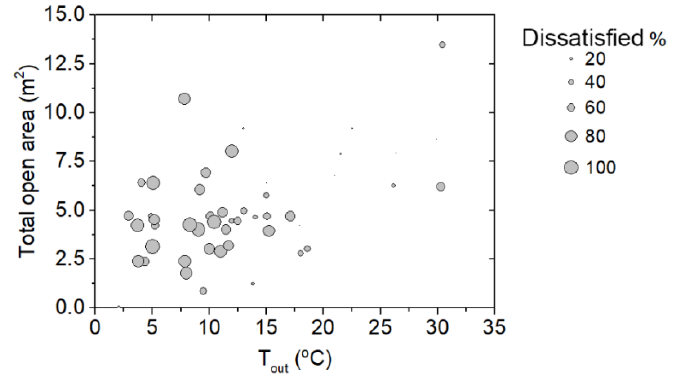
Figure 10. Relationship between the percentage of dissatisfied students, outdoor temperature and total area of open windows.